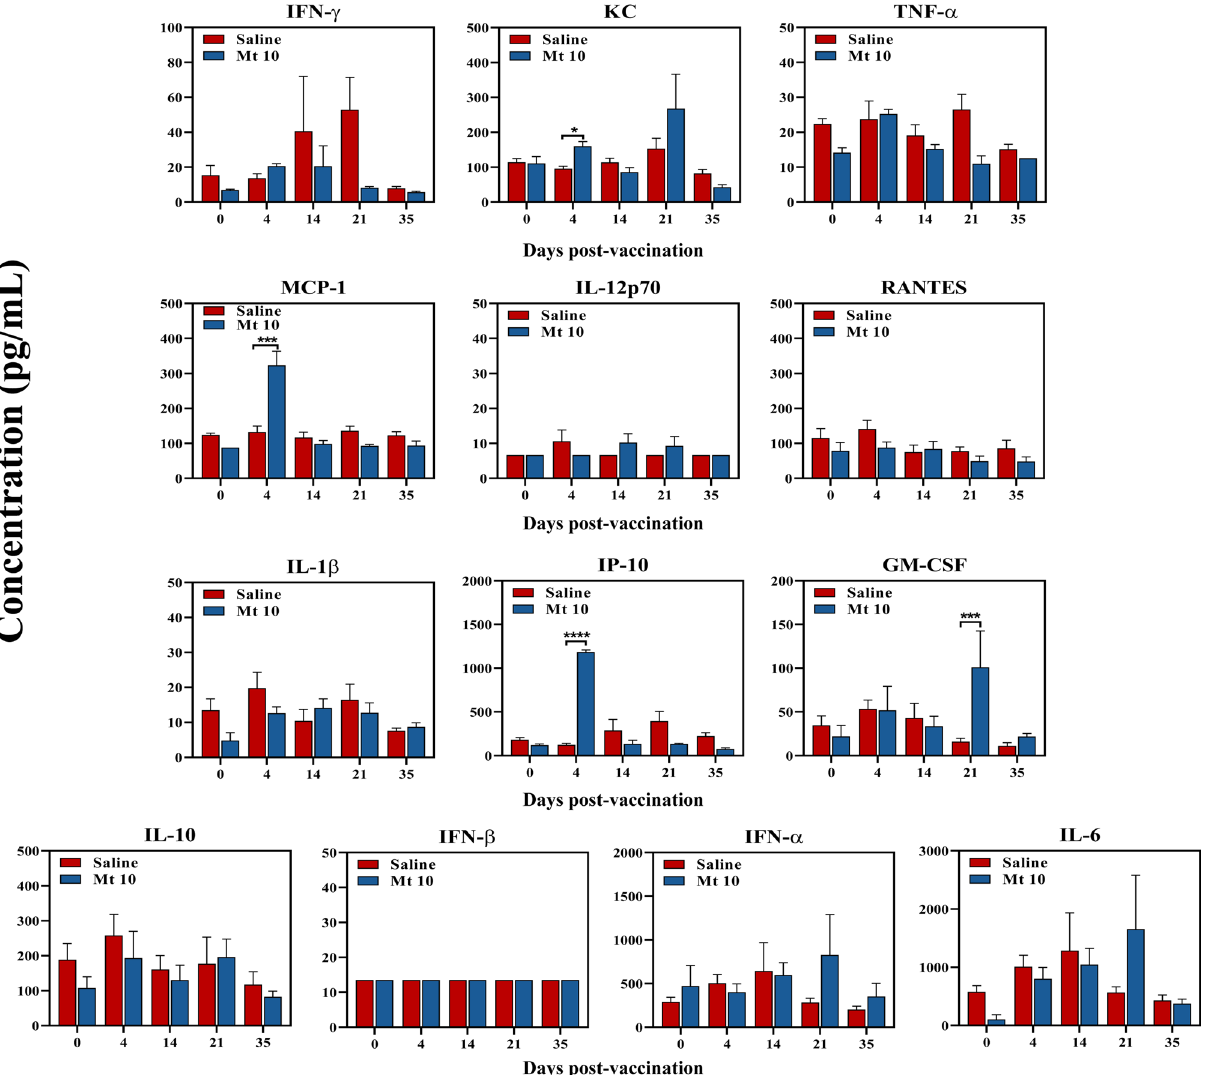
Figure 7. Analysis of anti-viral cytokines and chemokines in response to Mt 10 virus. Groups of mice were administered with saline or Mt 10 virus, and sera were collected periodically from day 0 to day 35. Samples were processed for a panel of indicated anti-viral cytokines and chemokines by LEGENDplex cytokine bead array as described in the methods section, and their levels were compared. Mean ± SEM values obtained from three individual experiments, each involving n = 3 to 8 mice are indicated. Unpaired Student’s t-test (two-tailed) was used to determine significance between groups. * p ≤ 0.05, *** p ≤ 0.001, and **** p ≤